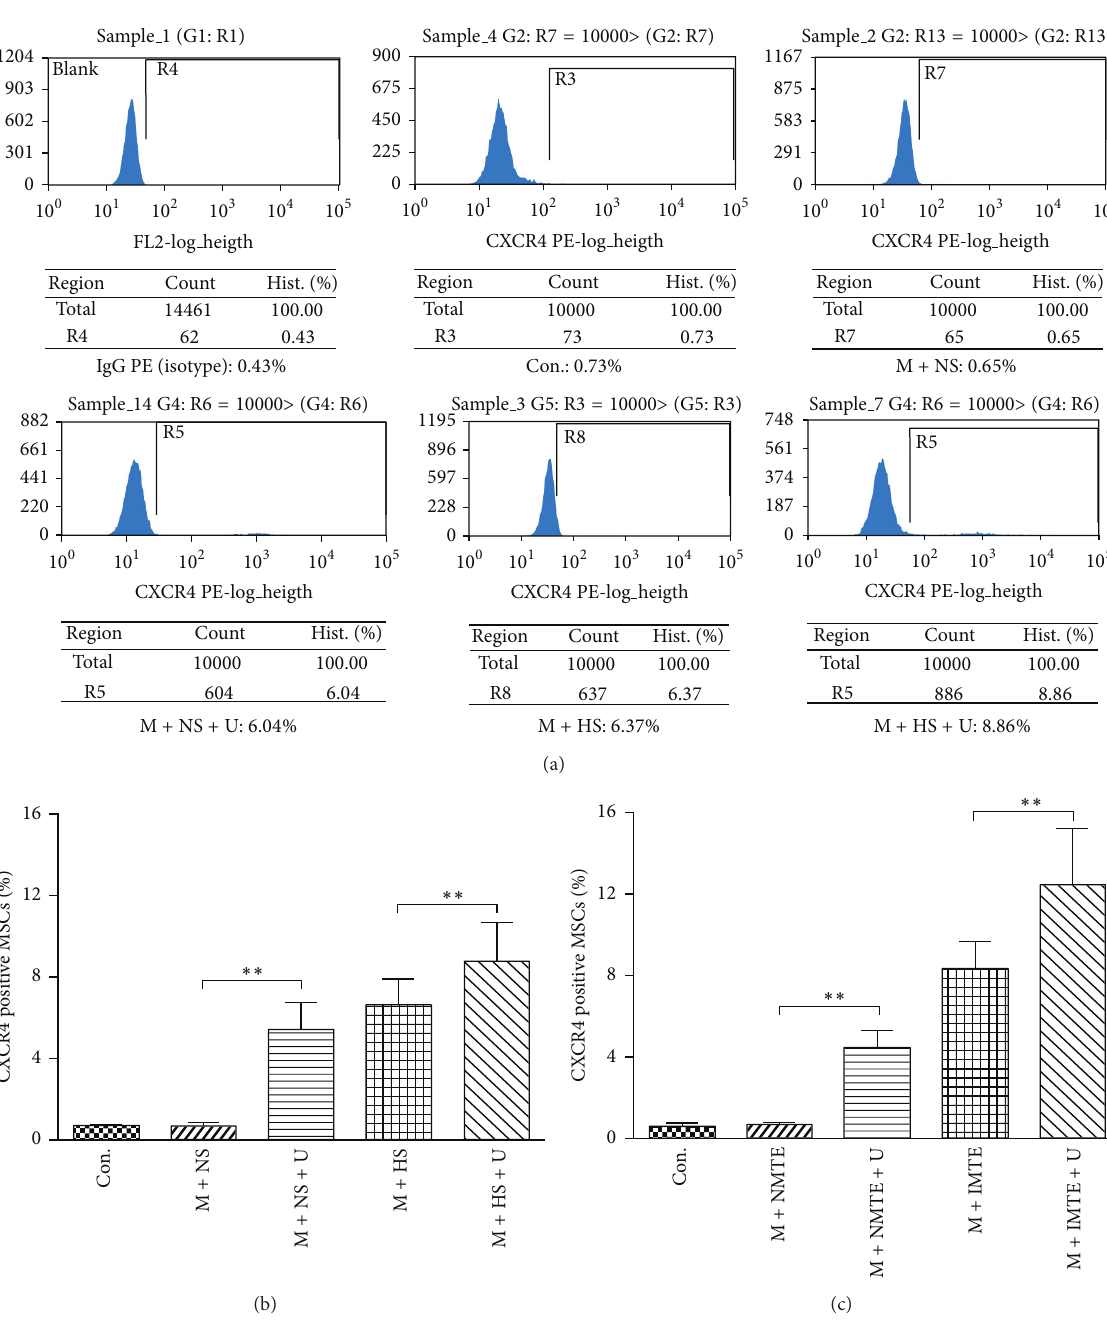
Figure 4: Cell surface expression of CXCR4 using FCM. (a) Representative examples of the membrane expression levels of CXCR4 on MSCs in the supernatant of the different groups. The percentage of MSCs positive for surface CXCR4 protein expression was valued as the number of cells expressing surface CXCR4/number of cells in total. (b) Quantification of cell surface CXCR4 protein expression in the supernatant groups. (c) Quantification of cell surface CXCR4 protein expression in the MTE groups. All values are expressed as the mean ± SD. ∗∗ 𝑃 < 0.01 ; 𝑛 = 6